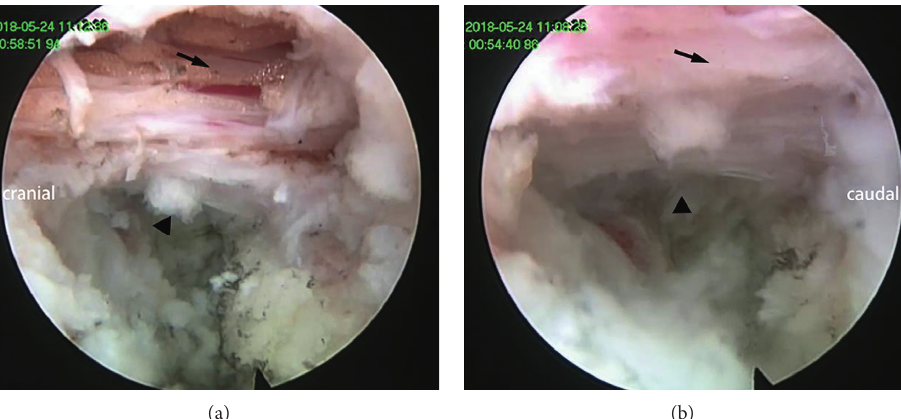
Figure 5: The decompressed central spinal canal (a) and lateral spinal canal under endoscopic view (b) showing the spinal cord and intervertebral space.